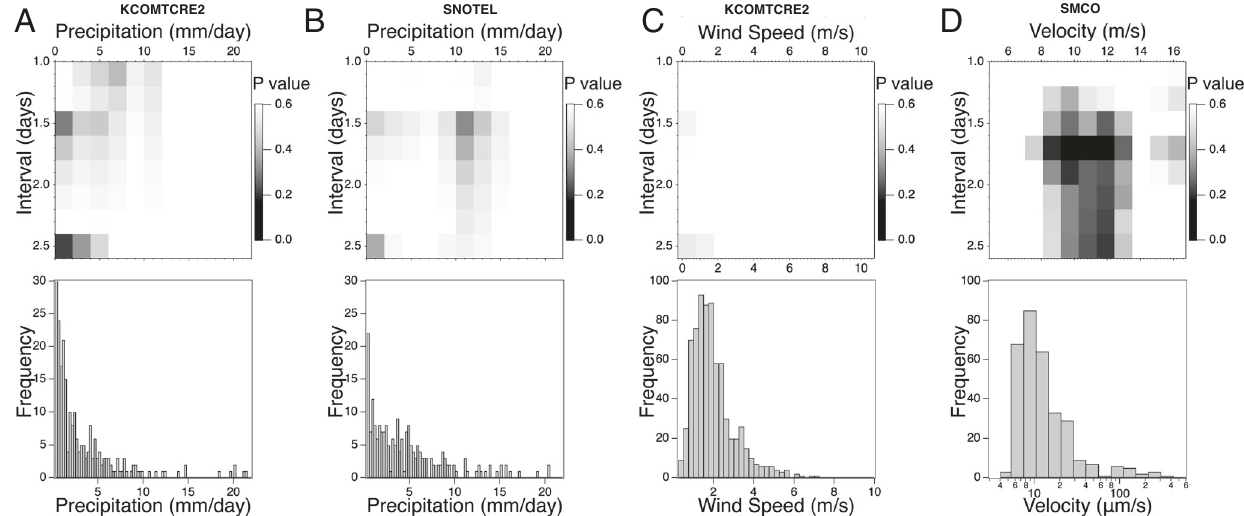
Fig. 2 | Parametric event coincidence analysis (ECA) for daily precipitation, wind and seismicity events preceding thorium excursion (top row) and histo- grams of daily precipitation totals, wind speed and ground motion (bottom row). A Precipitation data from KCOMTCRE2 weather station (location mapped in